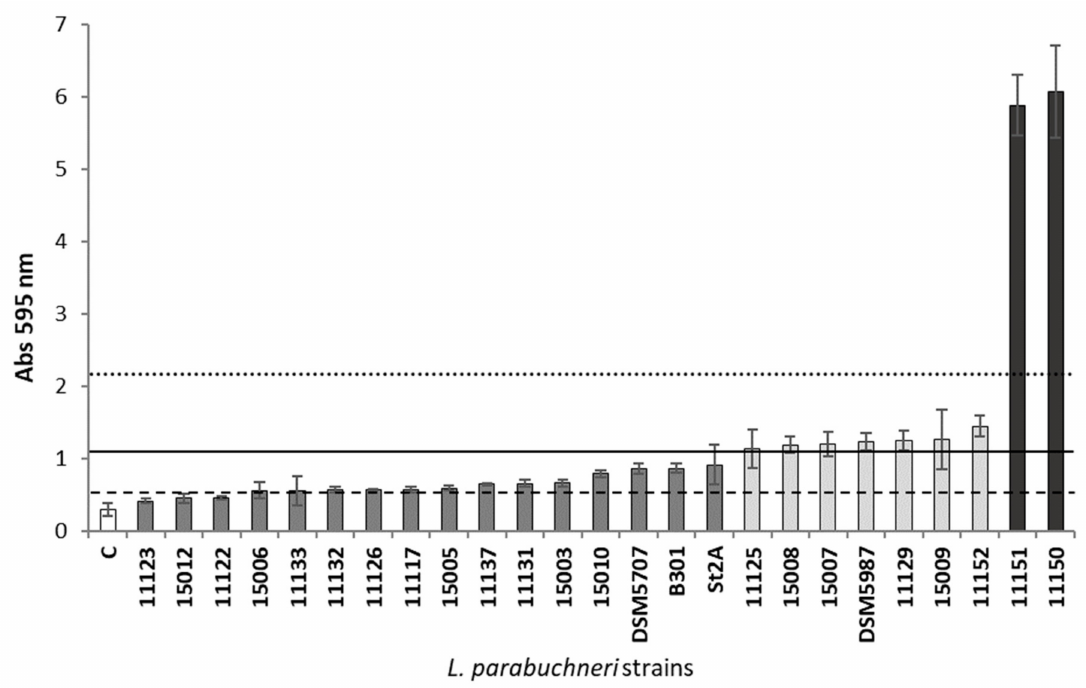
Figure 1. Biofilm-producing capacity on polystyrene of the histamine-producing Lentilactobacillus parabuchneri strains. The strains were incubated at 37 ◦ C for 48 h. Data represent means ± SD (error bars) of at least three independent experiments. Shading of the same color indicates no significant difference. The producer/nonproducer cut-off (weak producer) is signaled by the dashed line (ODc), the solid line is 2 × ODc (moderate producer) and the dotted line 4 × ODc (strong